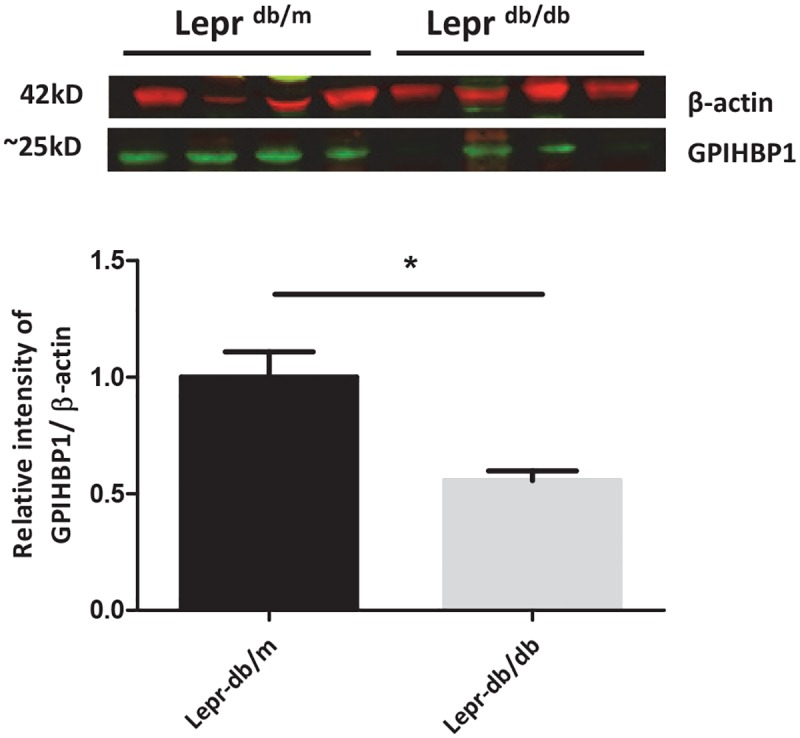
Representative blots for GPIHBP1 protein expression in visceral adipose tissue of Leprdb/m and Leprdb/db mice.Results are expressed as means ± SD; t-test statistics were used to test for differences between the groups. *P<0.05.